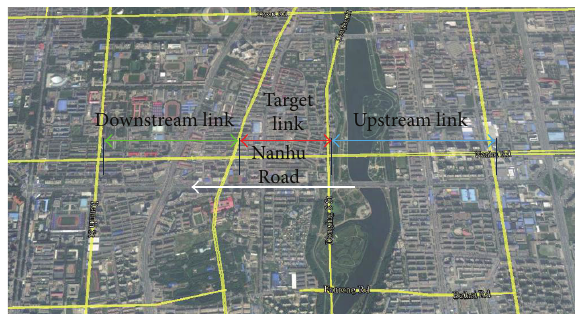
Figure 4: The case study arterial road in Changchun,